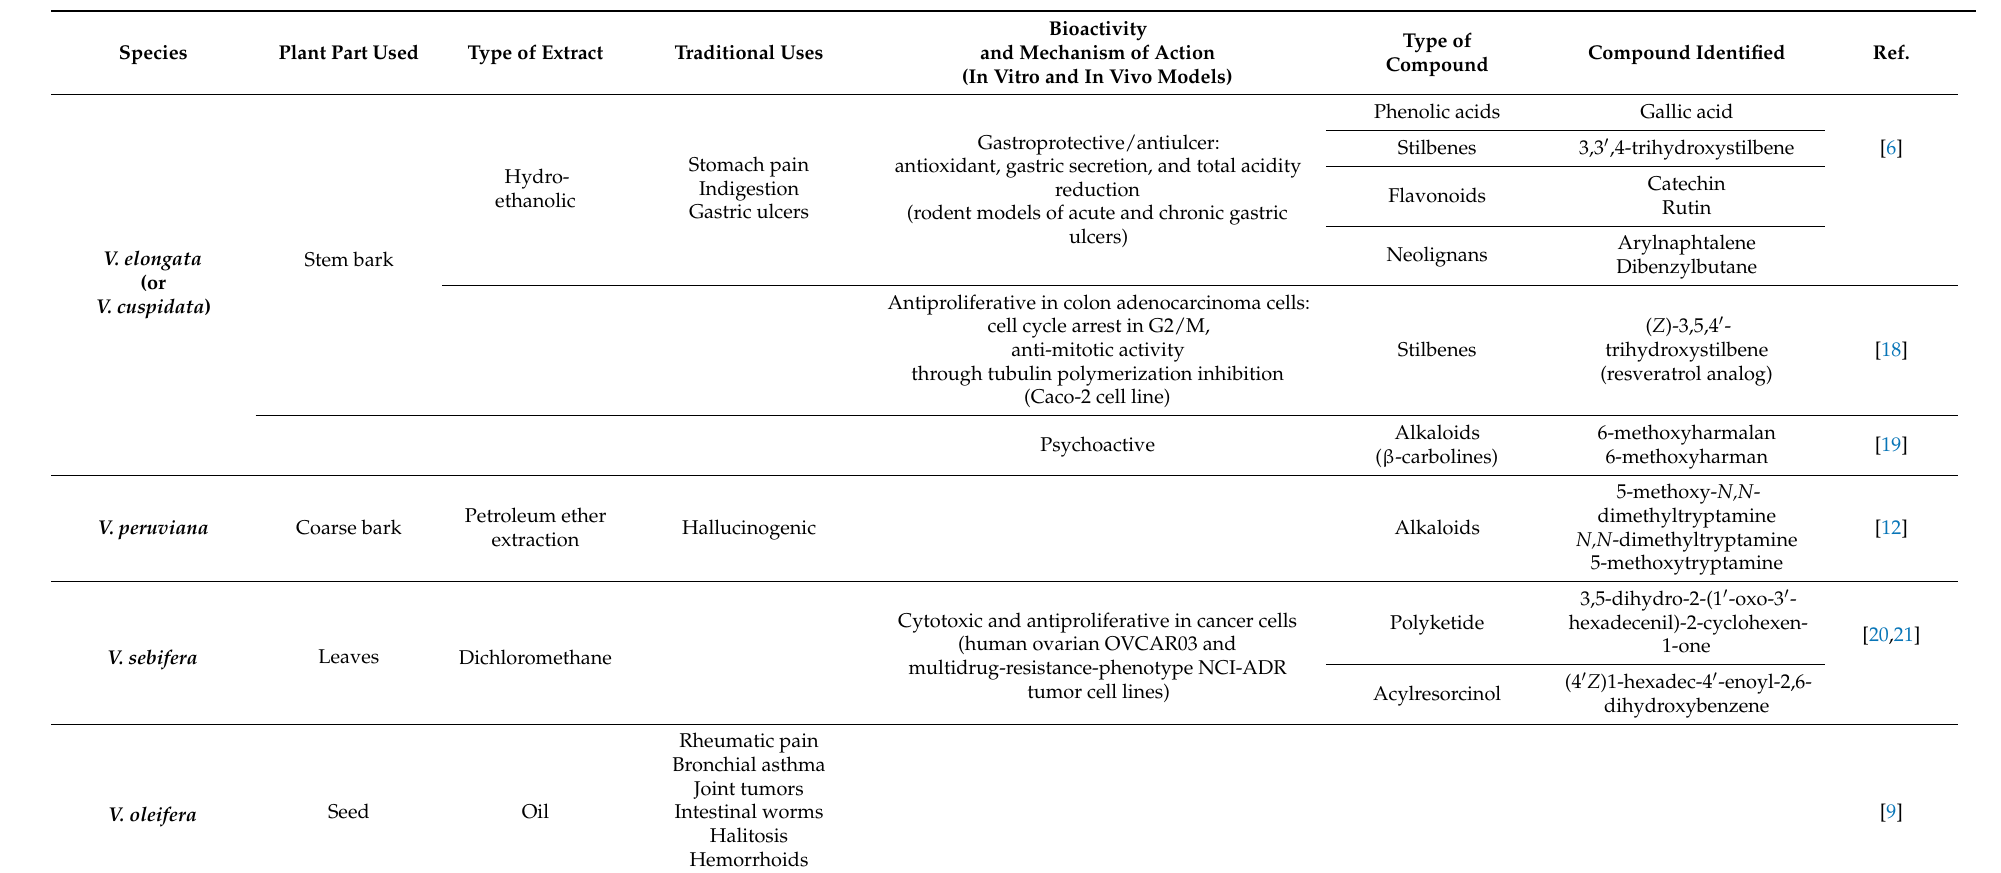
Table 1. Ethnomedicinal uses, biological activity, and bioactive phytochemicals of Virola